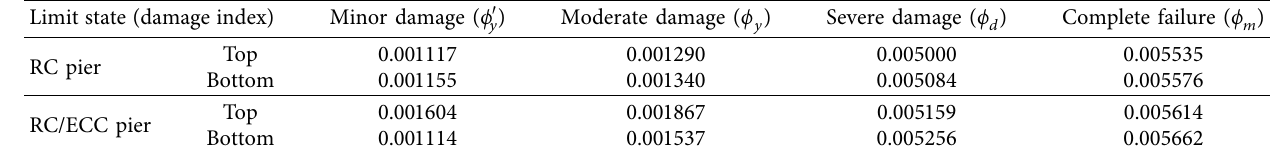
Table 3: Control section damage index of RC and RC/ECC